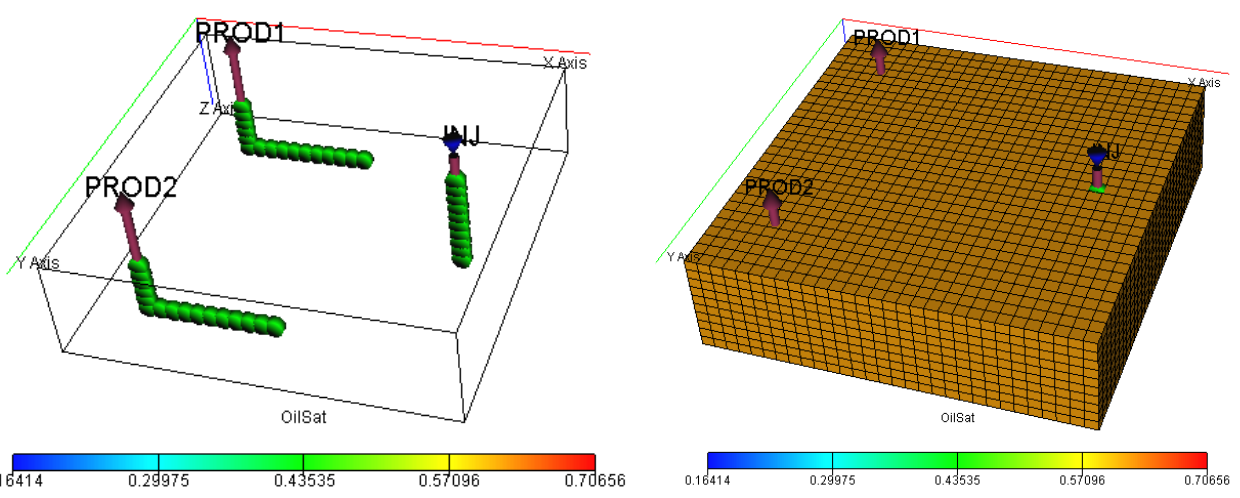
Figure 4. Map view of the location and position of two horizontal production wells and one vertical injection